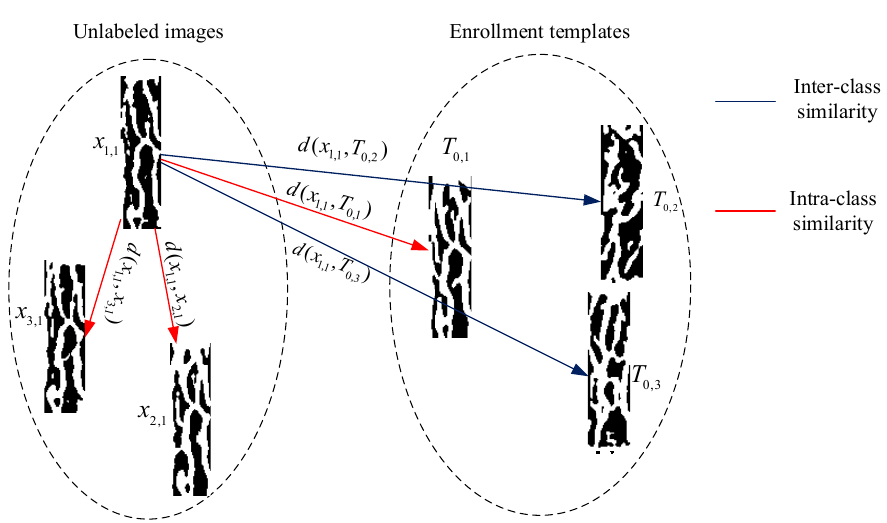
Figure 4. The intra-class similarity and inter-class similarity for unlabeled sample x 1,1